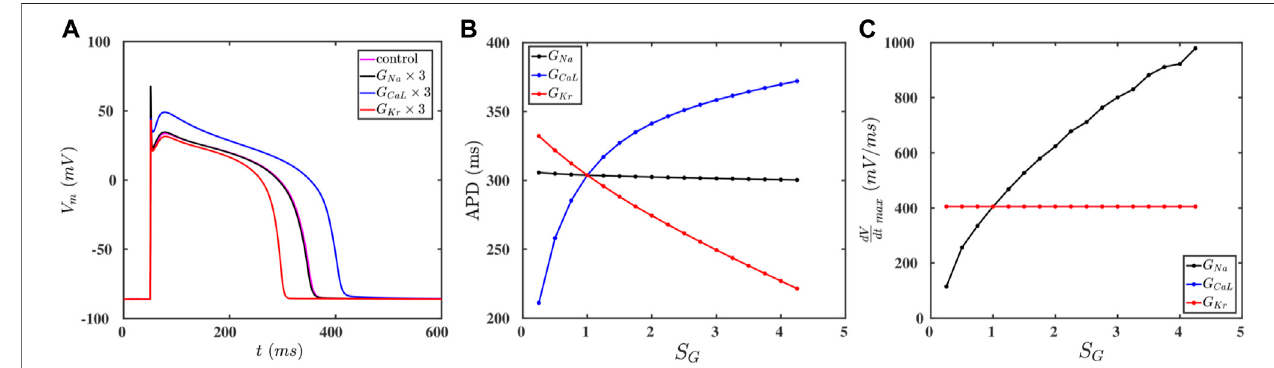
Frontiers in Physics |